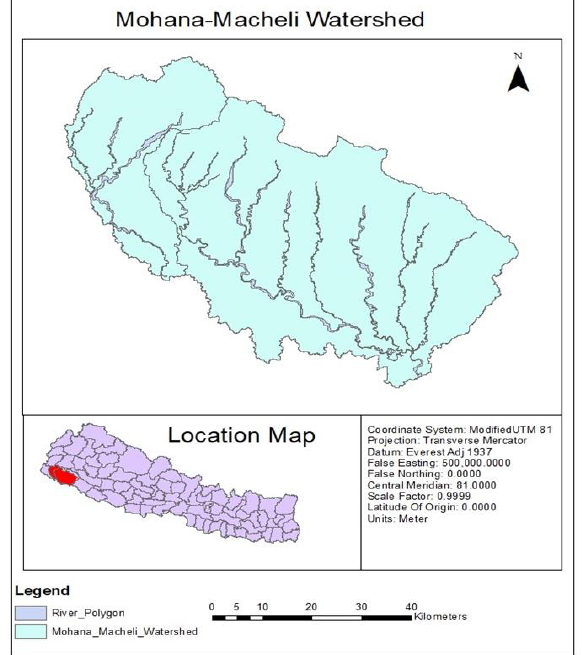
Fig 2: Study area (Mohana-Macheli Watershed Nepal)